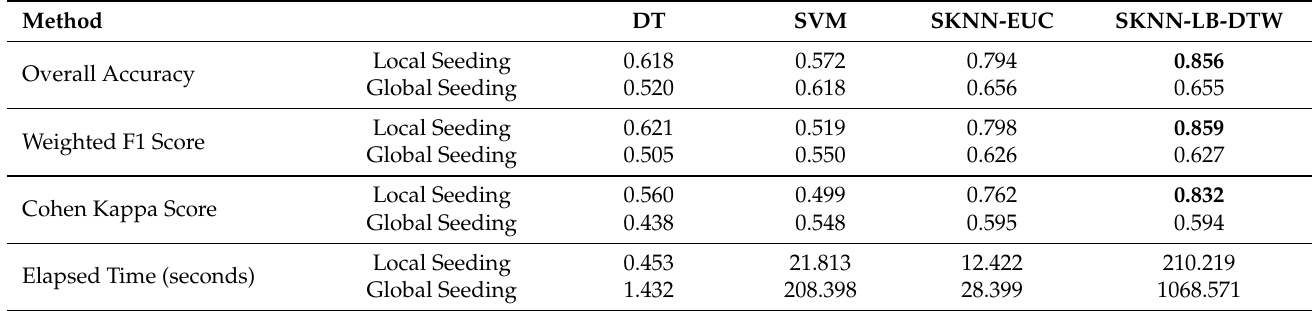
Table 4. Statistical comparison of the classification performance for the fourth grid.